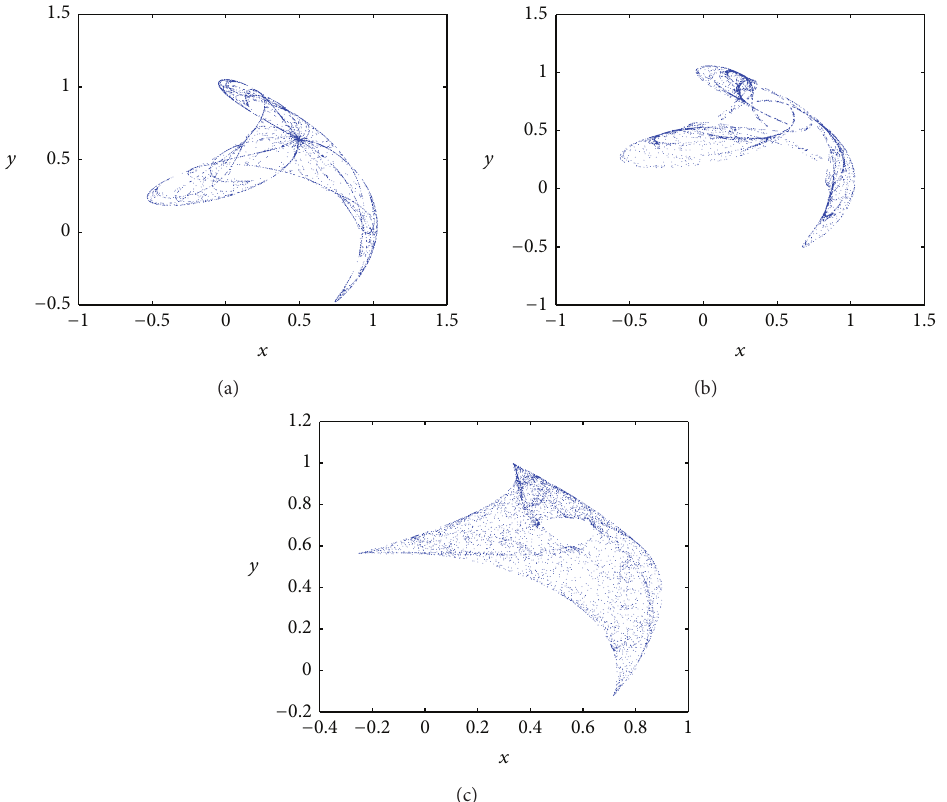
Figure 9: Phase portraits corresponding to Figure 8: (a) 𝑐 = 0.01 , (b) 𝑐 = 0.2 , and (c) 𝑐 = 0.45 .